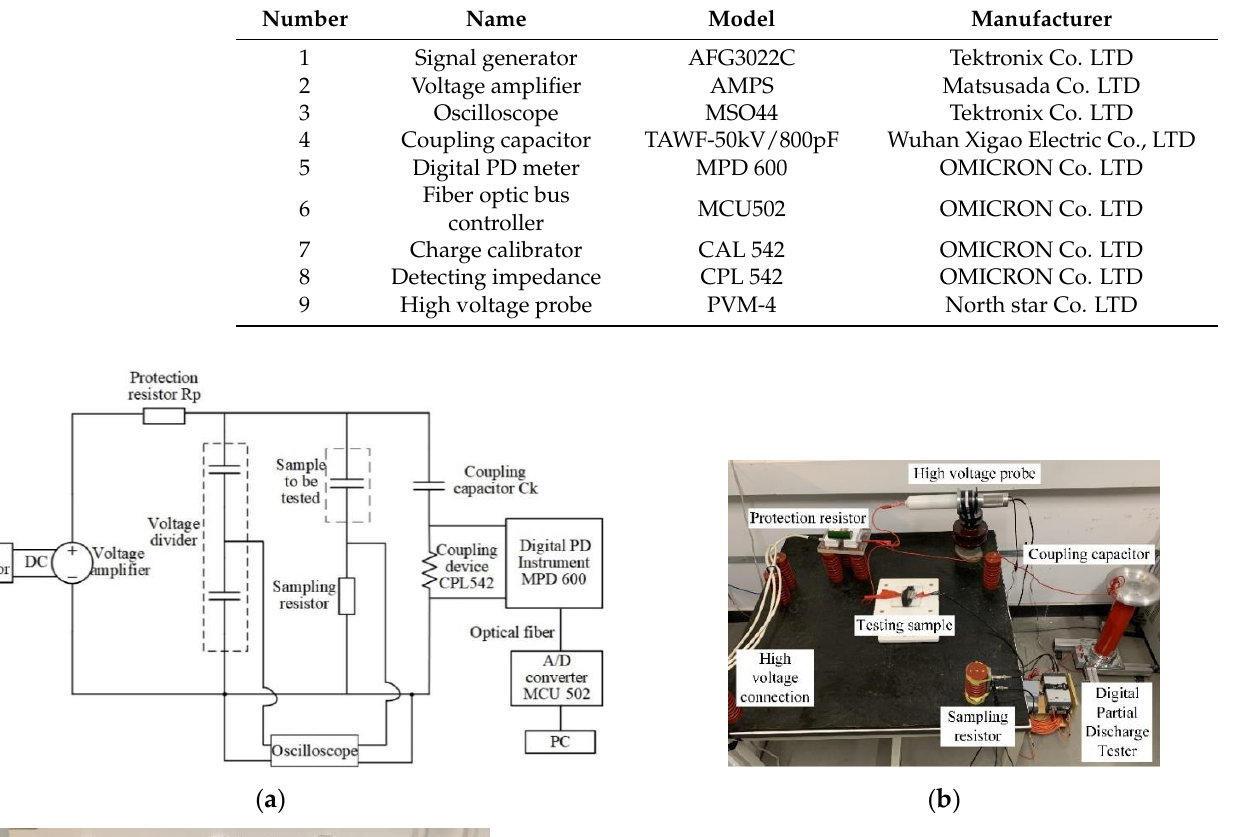
Table 4. Equipment for partial discharge testing.